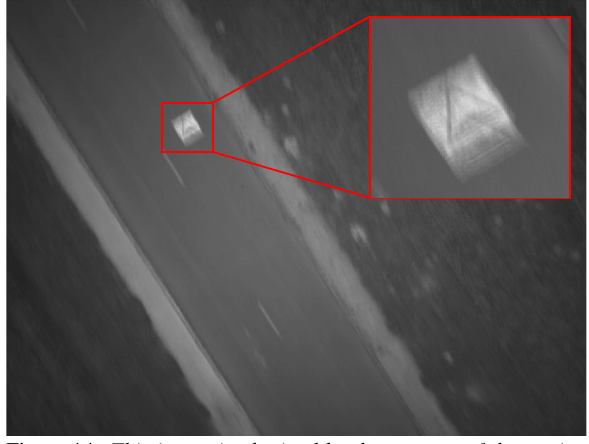
Figure 14. This image is obtained by the average of the ten im- ages. The angular motion between images is 0.9 degree corre- sponding to 44 pixels.